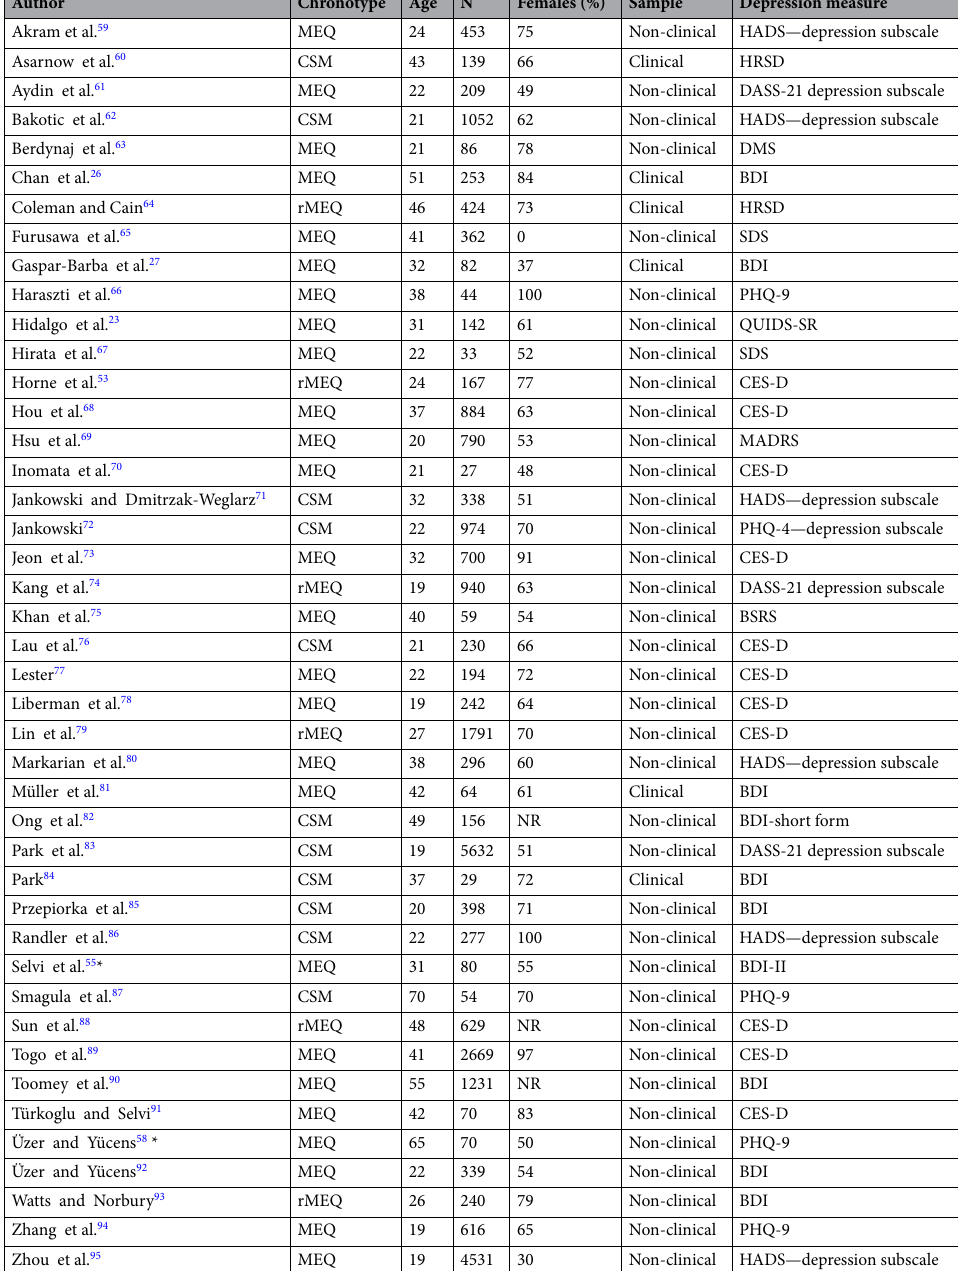
Table 1. Study characteristics. For abbreviations please see main text. *Two effect sizes were initially estimated for each of these studies two of which were subsequently identified outliers and excluded from the main random effects